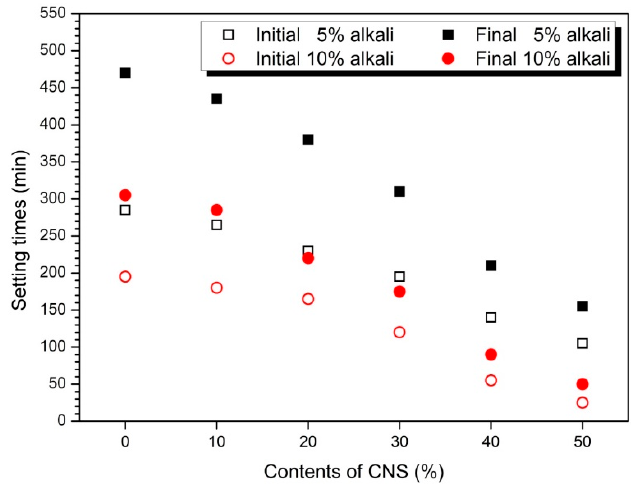
Figure 3. Setting times according to CNS replacement ratios in 5% and 10% activators.